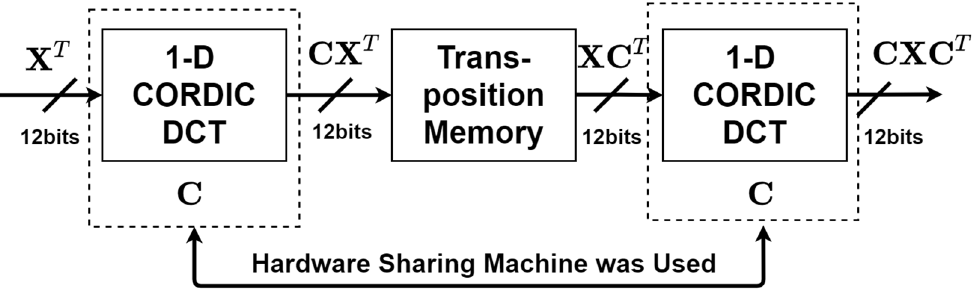
Figure 3. The two-dimensional discrete cosine transform (2-D DCT) realized by the row–column method based on the 1-D DCT.